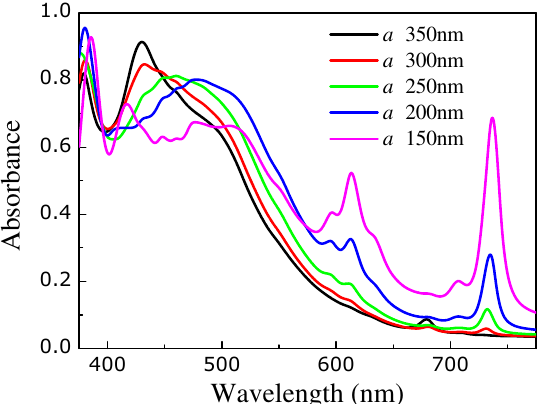
Figure 7. Absorbance of light incident normally on a square array of silver nanocubes with edge L = 70 nm, separated by a 8 nm polyelectrolyte ( ǫ = 2 . 37 ) spacer from a 50 nm thick gold substrate (see Figure 1), for different lattice constants, i.e. , a = 150 , 200 , 250 , 300 , 350 nm.